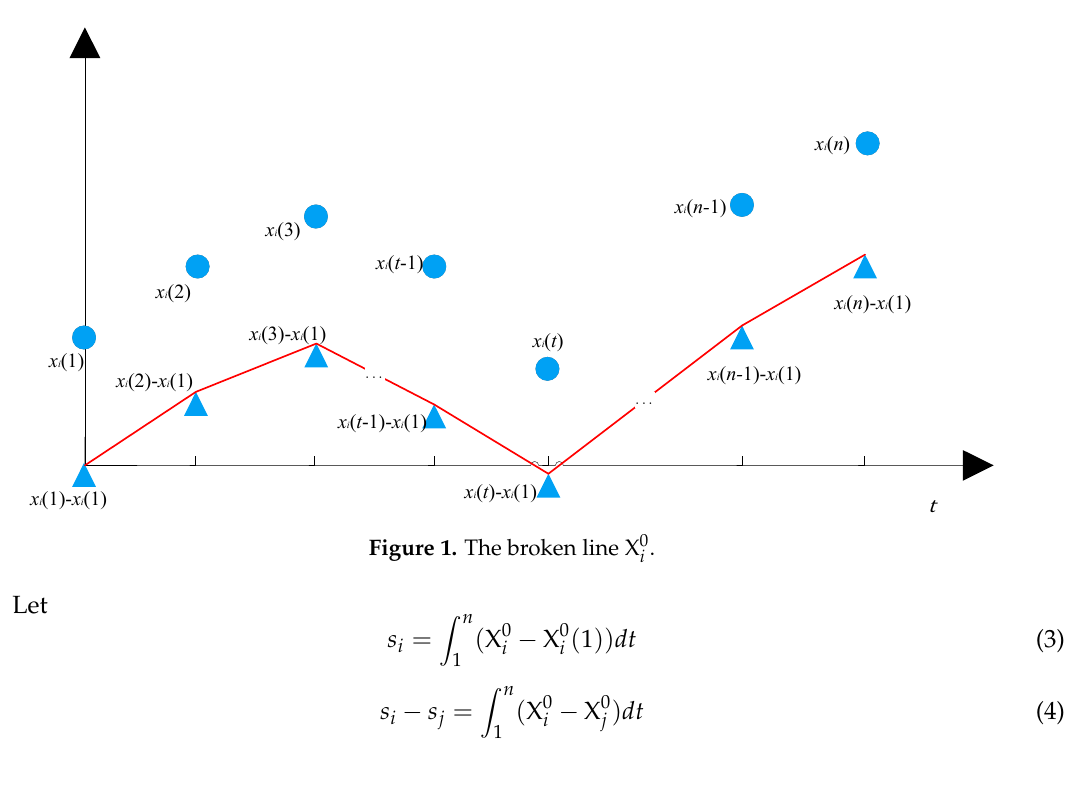
Figure 1. The broken line X 0 .